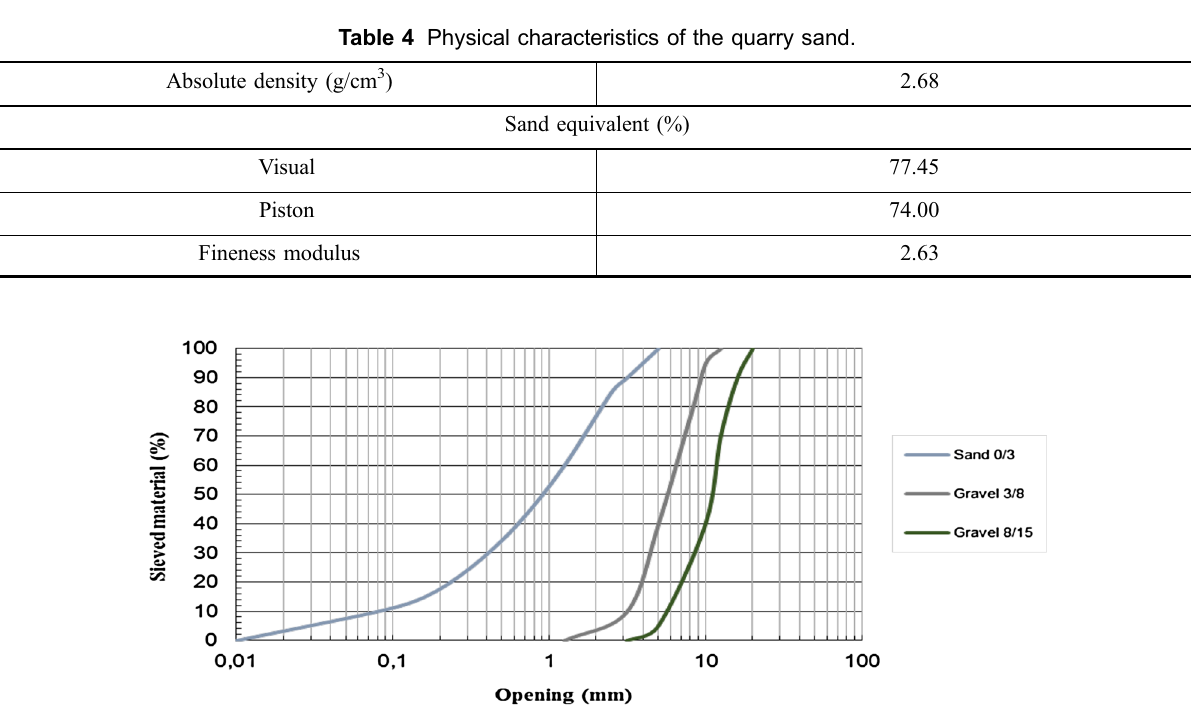
Fig. 6 Grain size distribution curves of